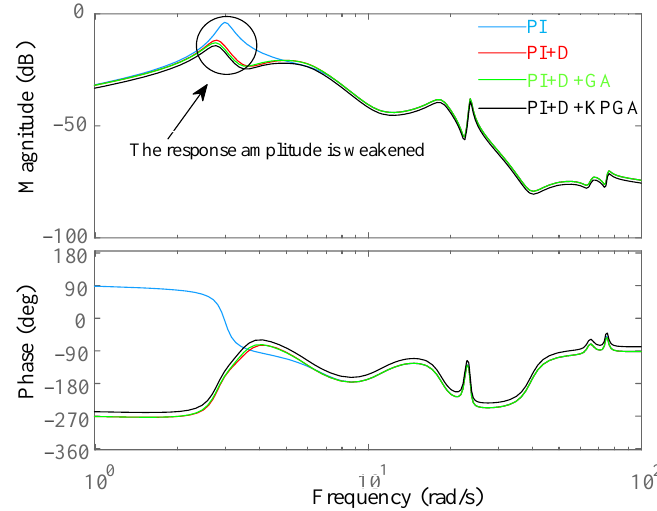
Figure 10. The active damping control Bode plot.